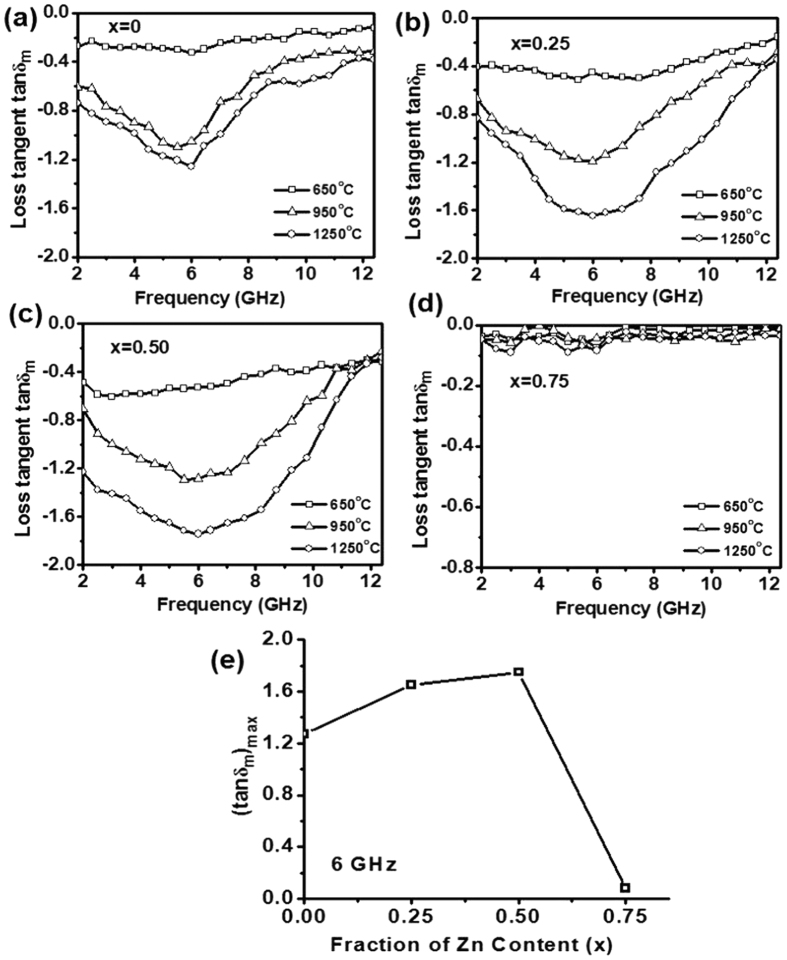
Frequency dependence of the loss tangent (tanδm) for annealed Ni1−xZnxFe2O4 powder (a) x = 0 (b) x = 0.25 (c) x = 0.50 (d) x = 0.75 (e) variation of maximum loss tangent with Zn concentration at resonating frequency of 6 GHz.